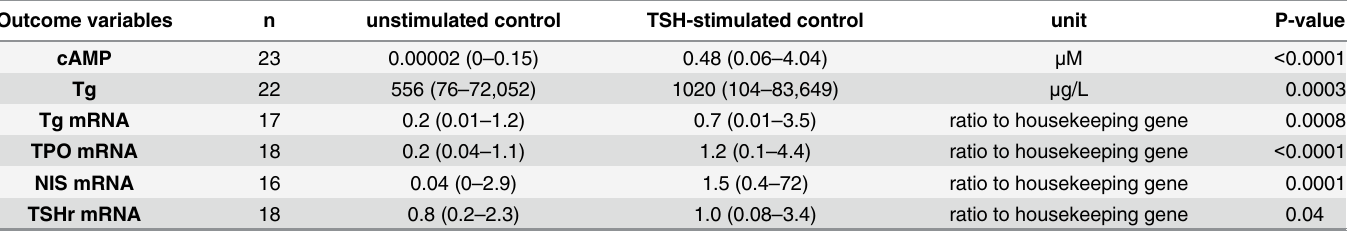
Table 1. Levels of outcome variables in un- and TSH-stimulated controls. Experiments were conducted in duplicates or triplicates and exposure time was 72 h. Log10-transformed data was used in statistical analysis. cAMP: 3'-5'-cyclic adenosine monophosphate. IL: interleukin. NIS: sodium iodine sympor- ter. Tg: thyroglobulin. TPO: thyroid peroxidase. TSHr: thyroid stimulating hormone receptor. Outcome